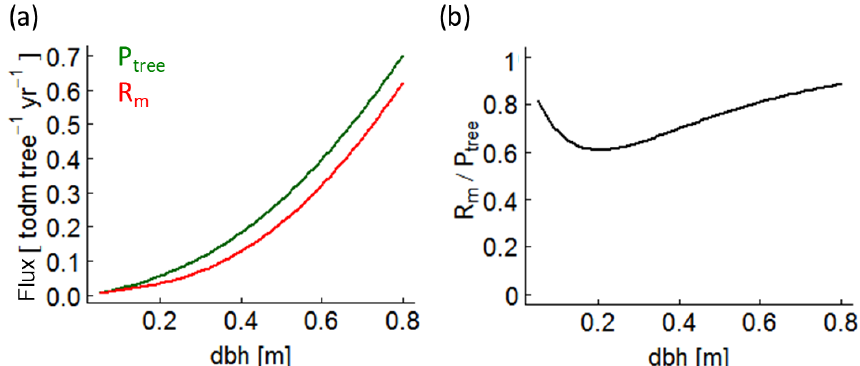
Figure B6. (a) Photosynthesis (green line – P tree ) and maintenance respiration (red line – R m ) rates of a single beech tree over stem diameter (dbh) under full light. (b) The ratio between maintenance respiration and photosynthesis of the same beech tree.